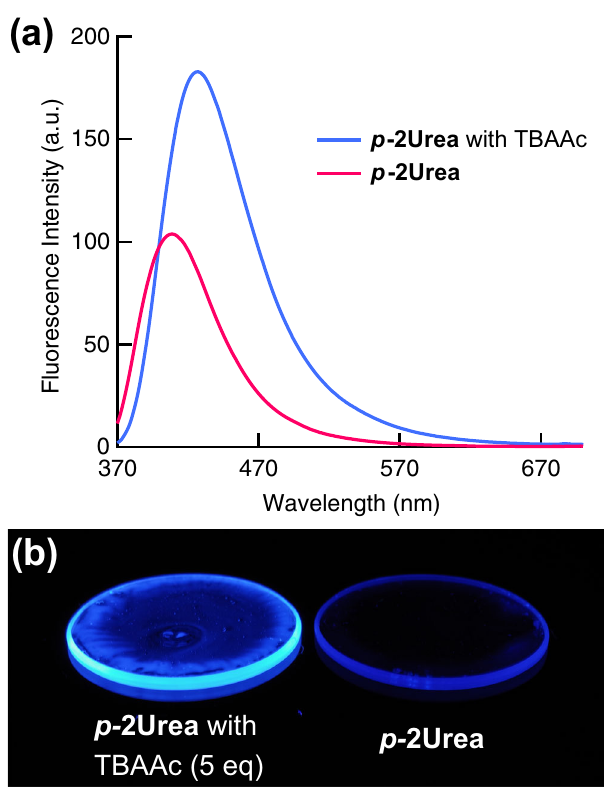
Fig. 6 Changes in fl uorescence with and without tetrabutylammonium acetate (TBAAc). a Solid-state fl uorescence spectra of p -2Ure a in the presence and absence of 5 equiv of TBAAc when excited at 340 nm. b Photographs of the same molar amount of p -2Urea with 5 equiv of TBAAc (left) and without TBAAc (right) on 30 mm diameter quartz plates prepared by drop-casting under 365 nm ultraviolet-lamp